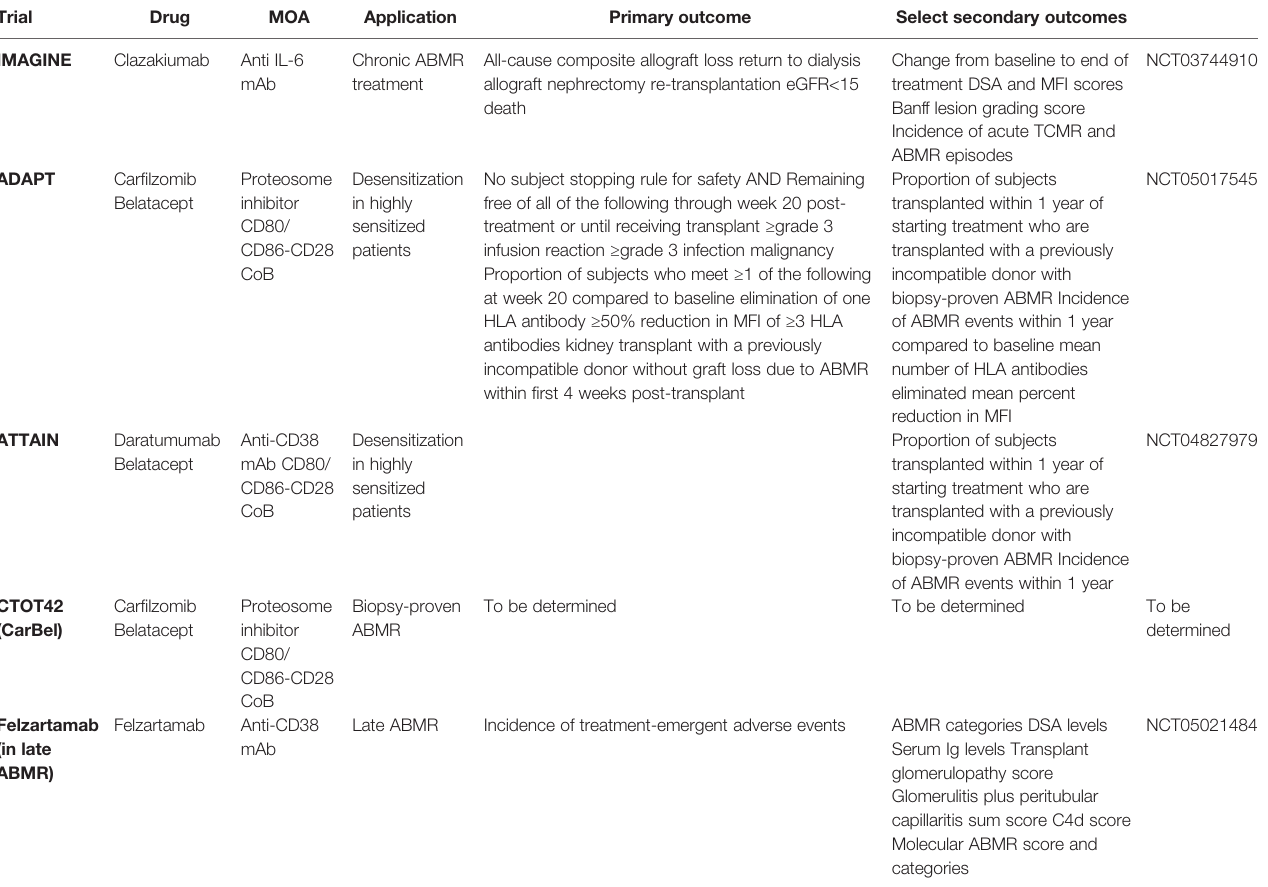
TABLE 2 | Summary of ongoing clinical trials for ABMR and desensitization